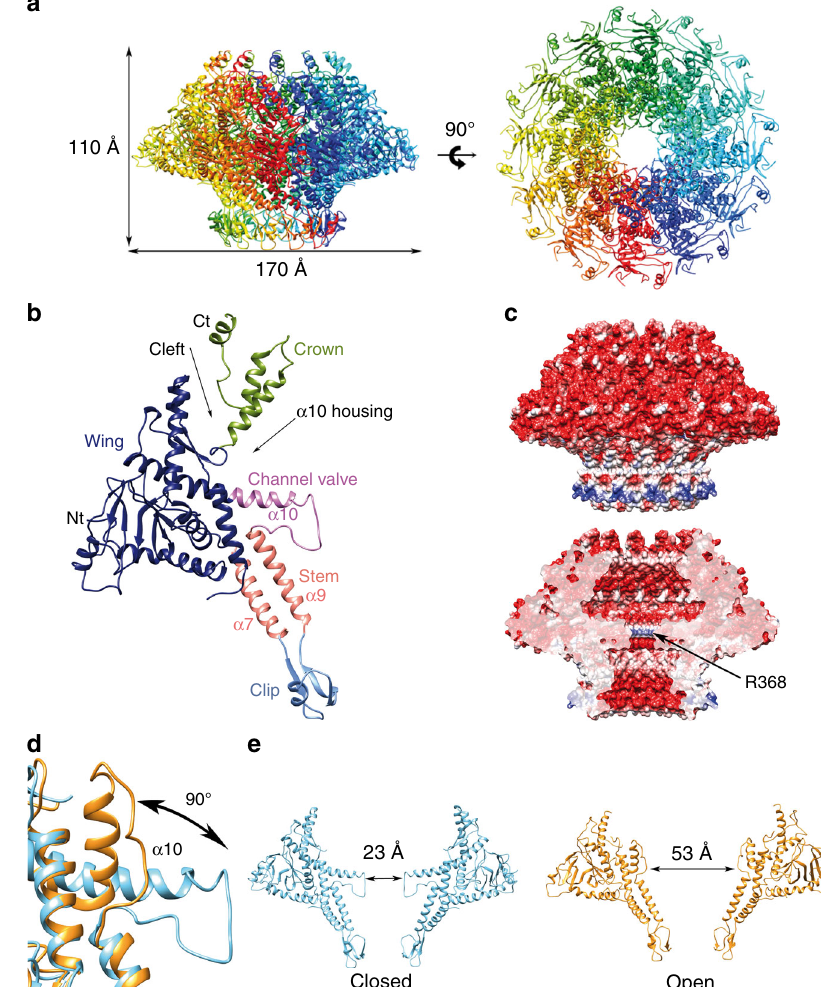
Fig. 1 Structure of the T7 bacteriophage portal. a Ribbon representation of the gp8 closed structure of the portal with rainbow coloring by monomer. The dimensions of the particle are indicated. Left, lateral view; right, axial view. b Ribbon representation of a monomer of the gp8 closed structure, colored by domains, with relevant secondary structure elements and structural features indicated. c Electrostatic potential on the external (up) and inner channel (down) surfaces of the gp8 closed portal. A thin positively charged channel ring, formed by R368, is indicated. d Detail of the superposition of gp8 closed (blue ribbon) and gp8 open structures (orange ribbon). The conformational change of the channel valve is indicated with an arrow and maximum torsion angle is shown. e Comparison of the two conformations by showing two opposed monomers. Left, closed conformation shown in blue ribbon. Right, open conformation shown in orange ribbon. The crown domain is not visible for the open conformation and has not been shown for the closed connector for the sake of